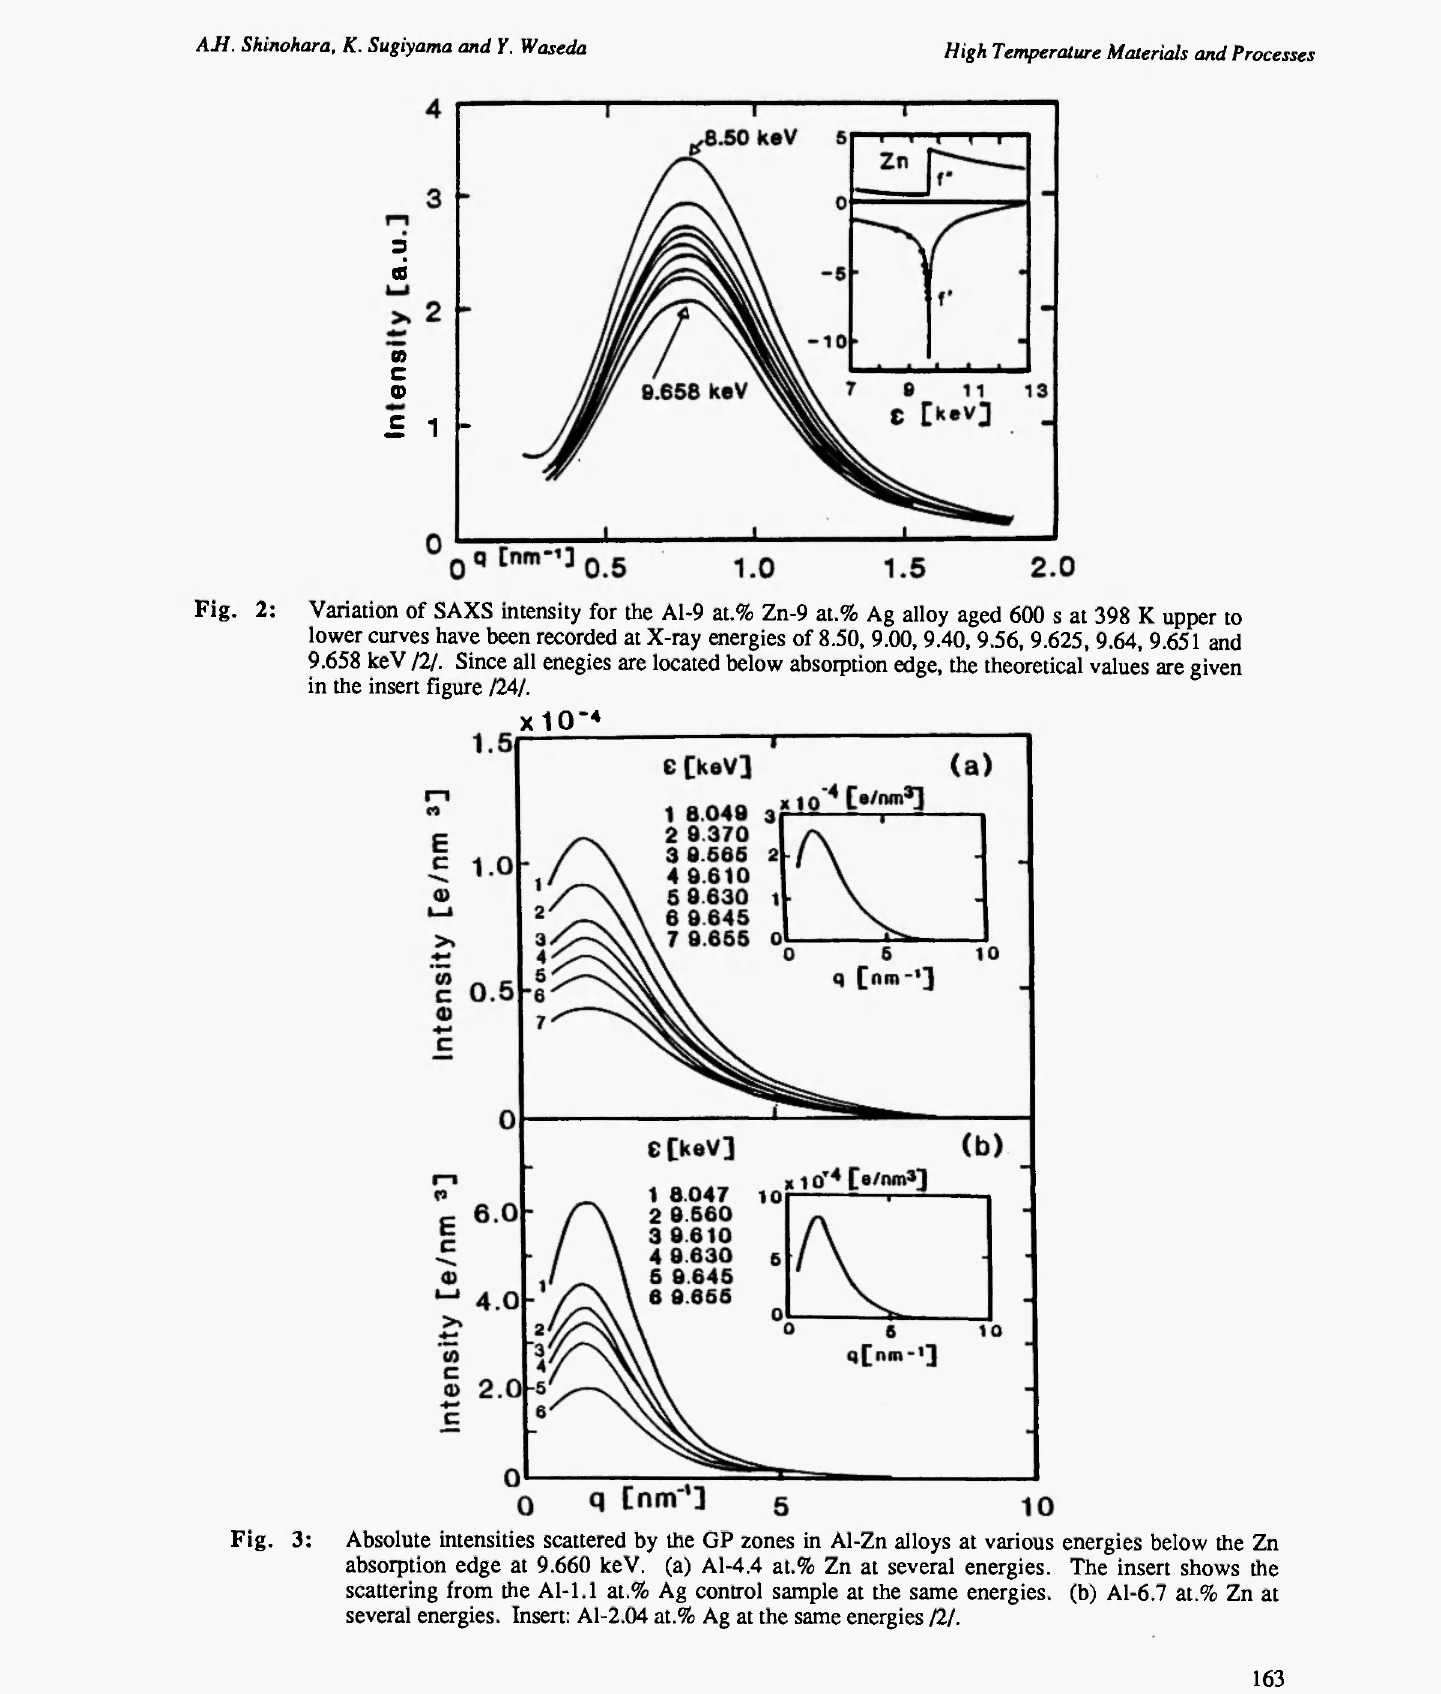
Fig. 3: Absolute intensities scattered by the GP zones in Al-Zn alloys at various energies below the Zn absorption edge at 9.660 keV. (a) Al-4.4 at.% Zn at several energies. The insert shows the scattering from the Al-1.1 at.% Ag control sample at the same energies, (b) Al-6.7 at.% Zn at several energies. Insert: Al-2.04 at.% Ag at the same energies /2/.